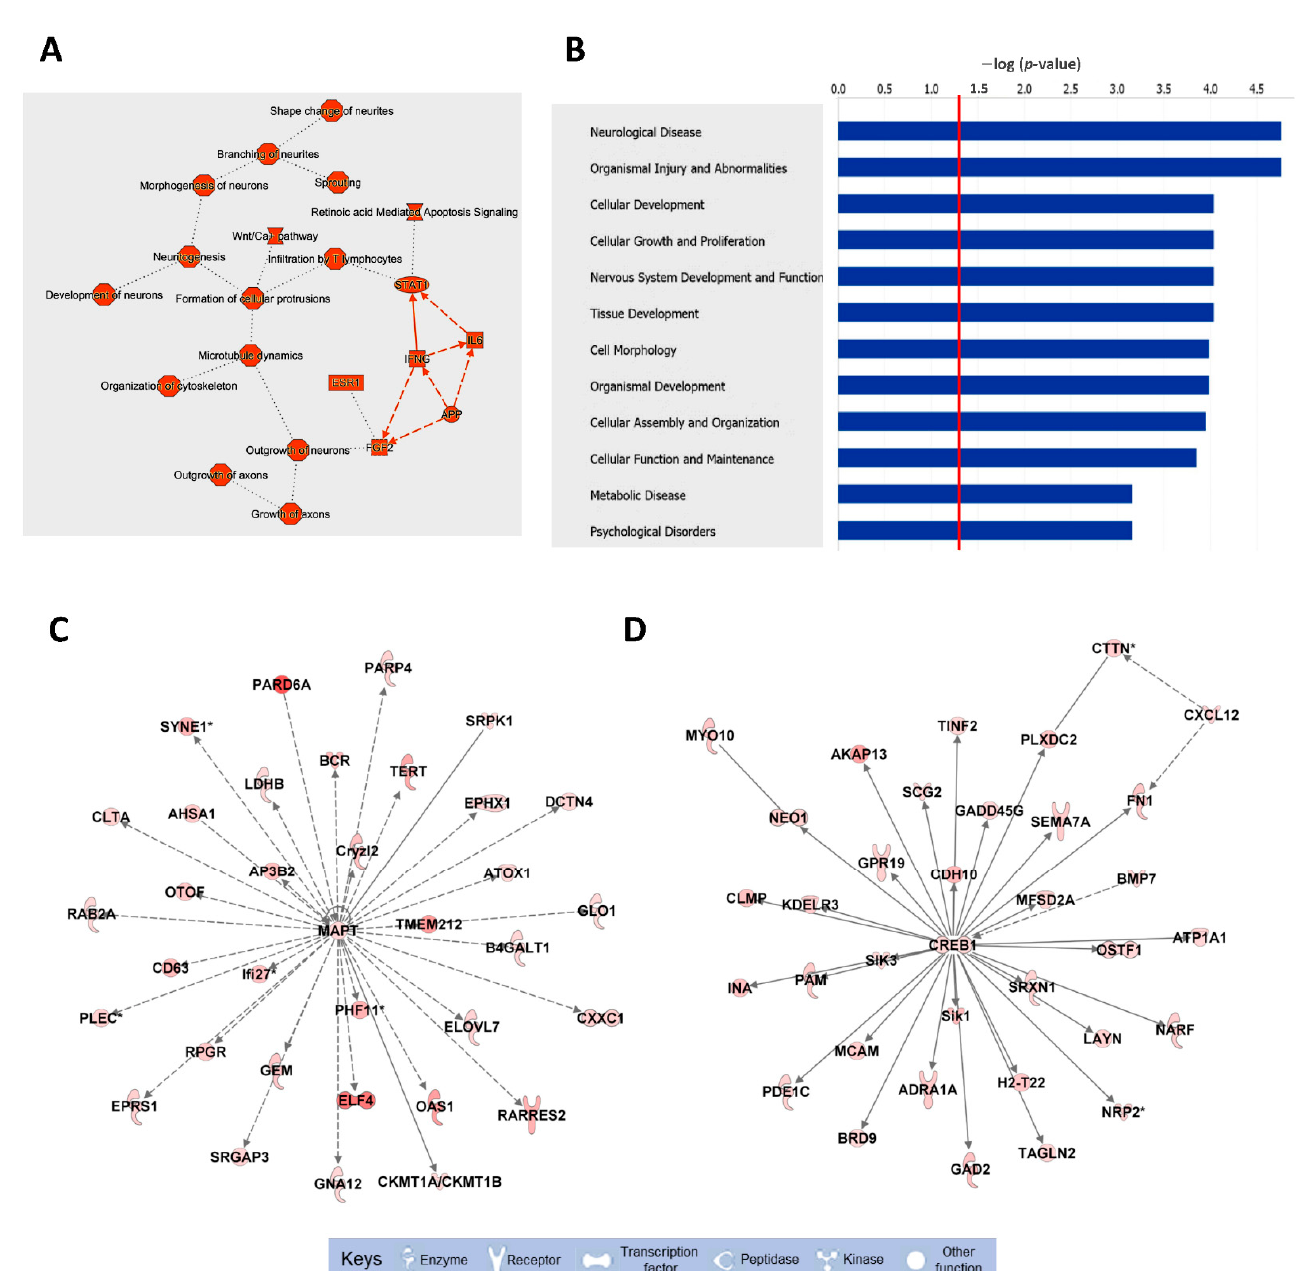
Figure 2. Biological pathways, diseases, and functions, and top molecular networks enriched in downregulated mRNAs in HuD KO striatum. The list of mRNAs significantly downregulated in HuD KO mice (Table S1) was imported to IPA for pathway analyses. ( A ) Top cellular pathways and ( B ) diseases and functions associated with downregulated mRNAs; the red line in ( B ) denotes a threshold of p = 0.05. ( C , D ) Top biological networks affected in HuD KO mice: ( C ) Molecules related to behavior and ( D ) cell morphology. Keys of the biological functions corresponding to the protein symbols in the networks are shown at the bottom of the figure. Note that these pathways are centered in two validated HuD targets, the MAPT and CREB1 mRNAs. The shades of red inside the protein symbols indicate the extent of downregulation of the corresponding mRNAs in HuD KO striatum, from a 5.6-fold downregulation of the PARD6A mRNA and a 4.9-fold downregulation of ELF4 mRNA, to a 1.3-fold downregulation of MAPT and CREB1 mRNAs. Solid lines denote direct interactions between proteins while indirect interactions are shown in dashed